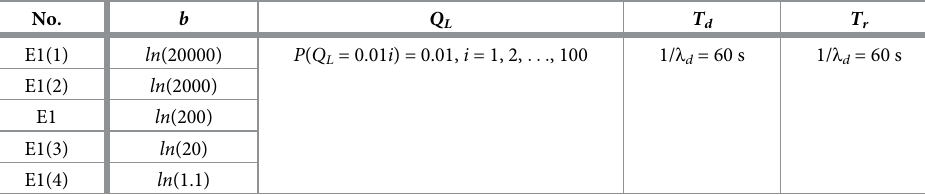
Table 5. Experiments to find the effect of b on the resilience distribution.